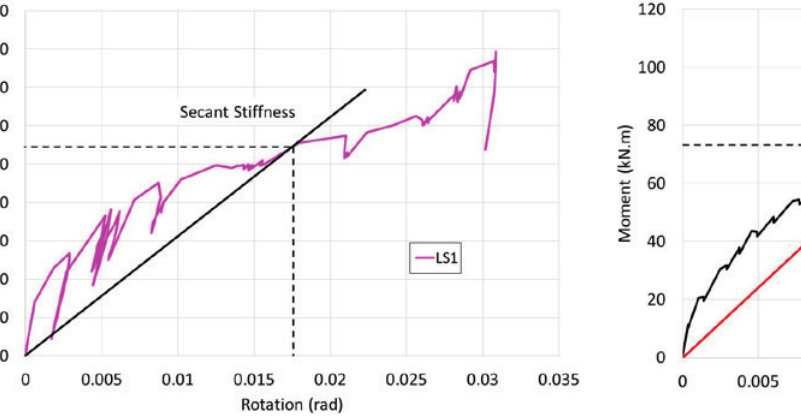
Figure 22 – Moment-rotation curve: specimens LS1 and